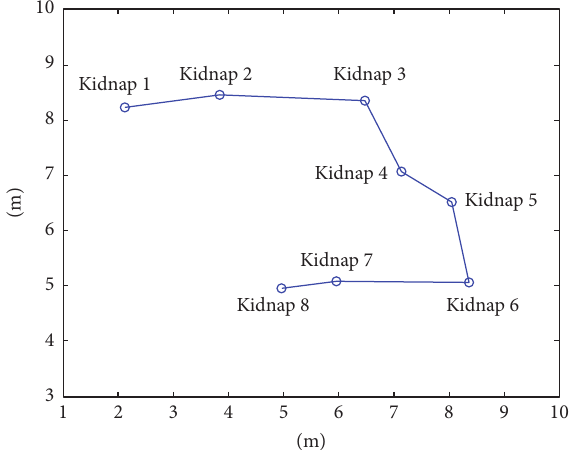
Figure 18: The kidnap experiment; eight consecutive kidnaps were executed by experimenters, and sign “o” is the localization result for each kidnap position fix by the robot after